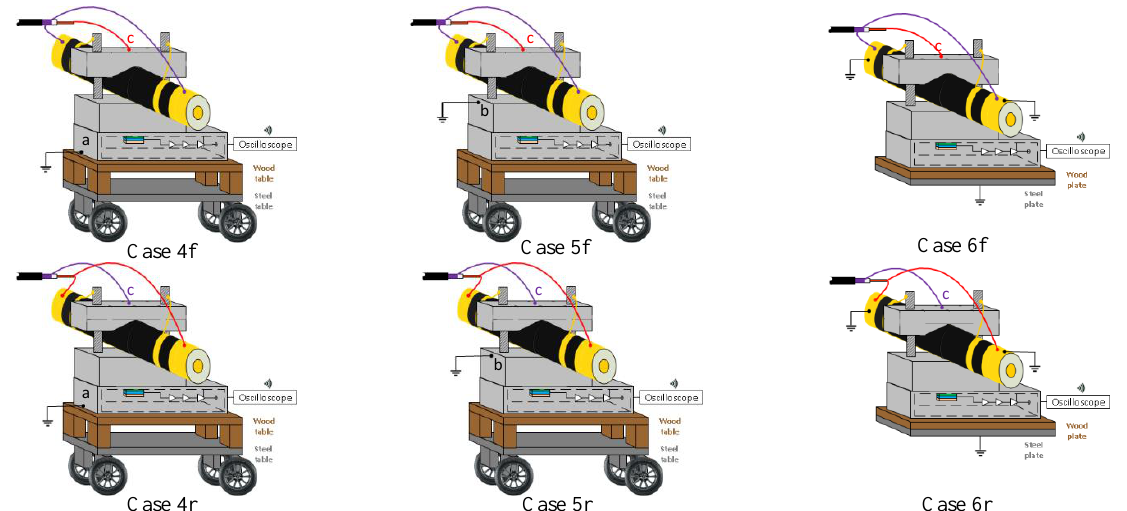
Figure 9. A 3D representation of the pulsed voltage connection locations for Cases 4f, 4r, 5f, 5r, 6f and 6r. Each of these cases has a different current distribution across the PEA test cell, with a different impact on the piezo amplifier interference. The connection between the test cell and the guard is done through the yellow cables at the mechanical pressure screws.